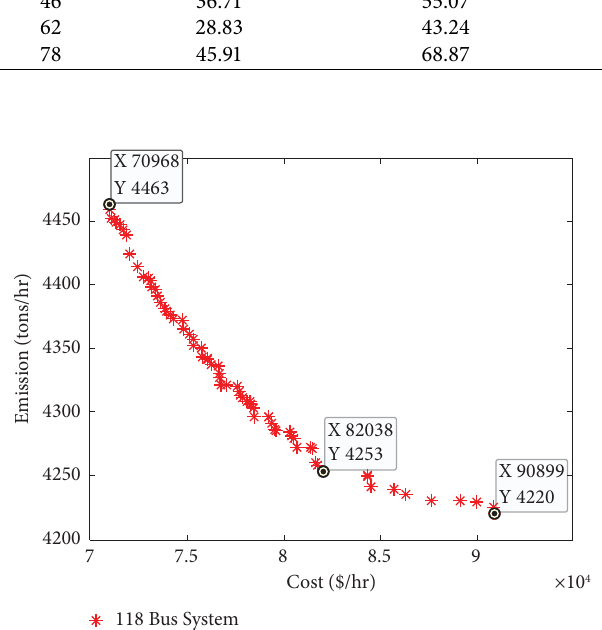
Figure 12: Pareto-optimal fronts obtained for IEEE 118-bus system.